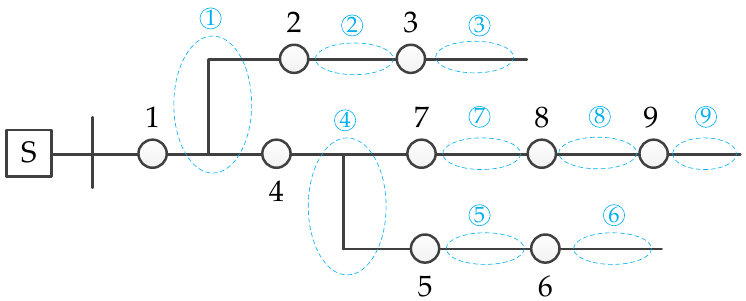
Figure 1. A typical radial distribution network.